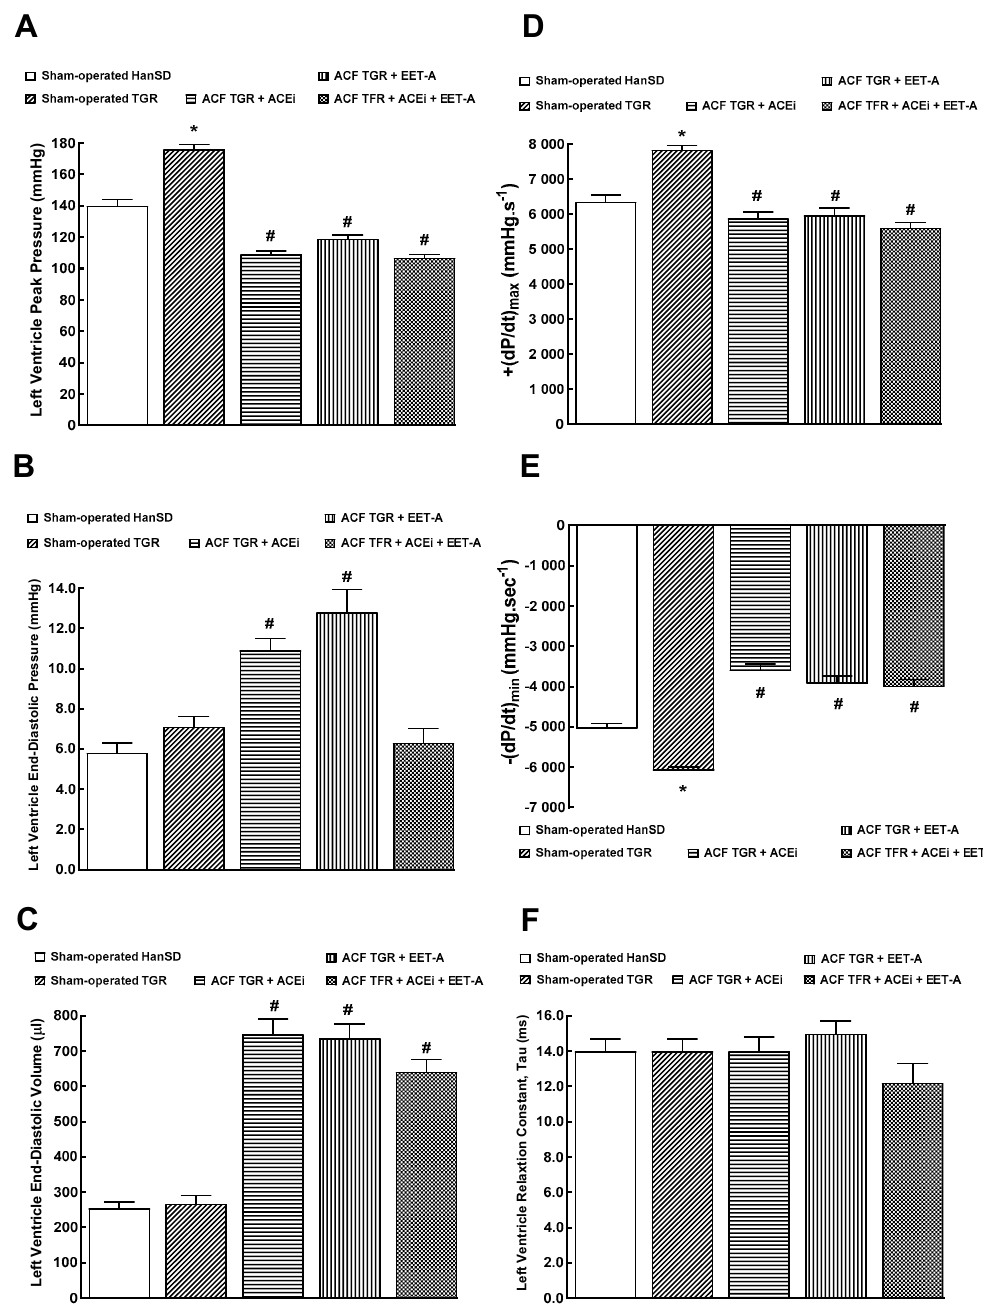
Figure 7. Part 1 of the left ventricular cardiac function assessment by invasive hemodynamic analysis performed 22 weeks after creation of the aorto-caval fistula (ACF) and 20 weeks after initiation of treatment in sham-operated transgene-negative Hannover Sprague-Dawley (HanSD), sham-operated heterozygous Ren-2 transgenic rats (TGR) and TGR rats with ACF treated with angiotensin-converting enzyme inhibitor (ACEi) alone or with 14,15-epoxyeicosatrienoic acid analog (EET-A) alone or with the combination of EET-A and ACEi. Left ventricle peak pressure ( A ), left ventricle end-diastolic pressure ( B ), left ventricle end-diastolic volume ( C ), maximum rates of pressure rise (+dP/dt) max ( D ), maximum rates of pressure fall (-dP/dt) max ( E ), relaxation constant tau ( F ). * p < 0.05 for sham-operated TGR versus sham-operated HanSD rats. # p < 0.05 for ACF TGR versus sham-operated TGR.